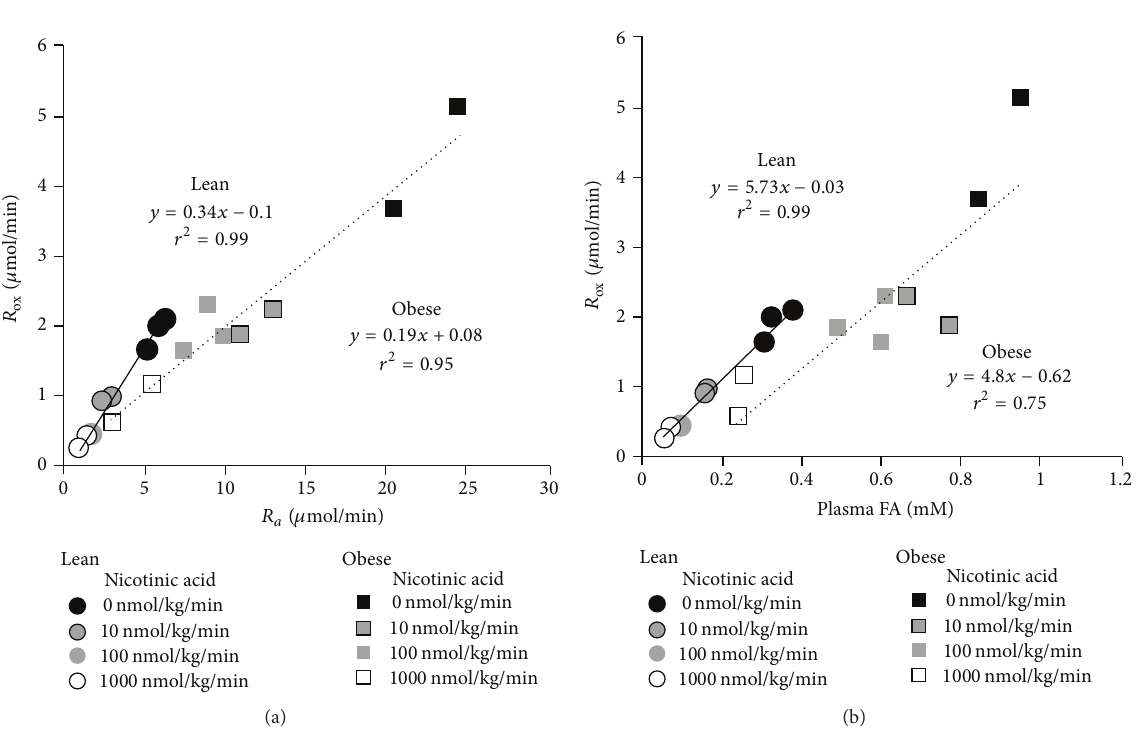
∗ were estimated from 𝑅 𝑓 values (Table 3) using procedures described in the Materials and Methods